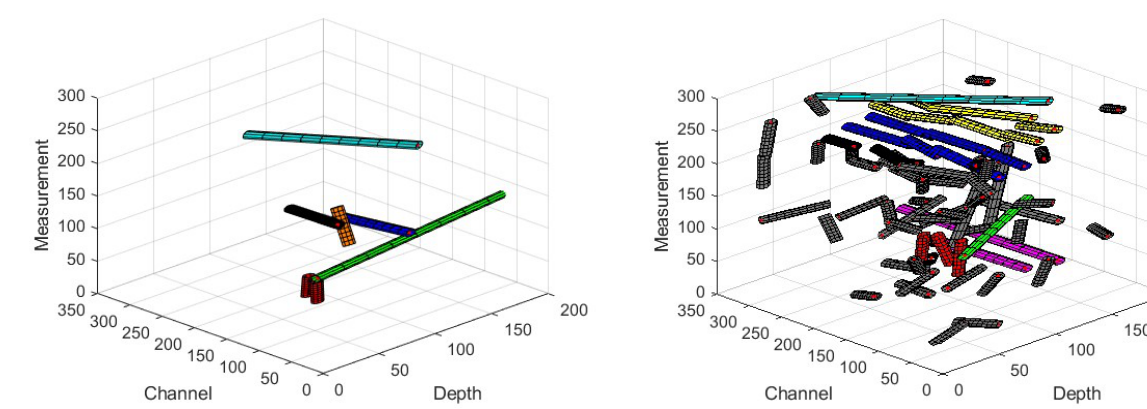
Figure 16 . Visualization of reference pipes. Figure 17 . Detected pipes with marked reference